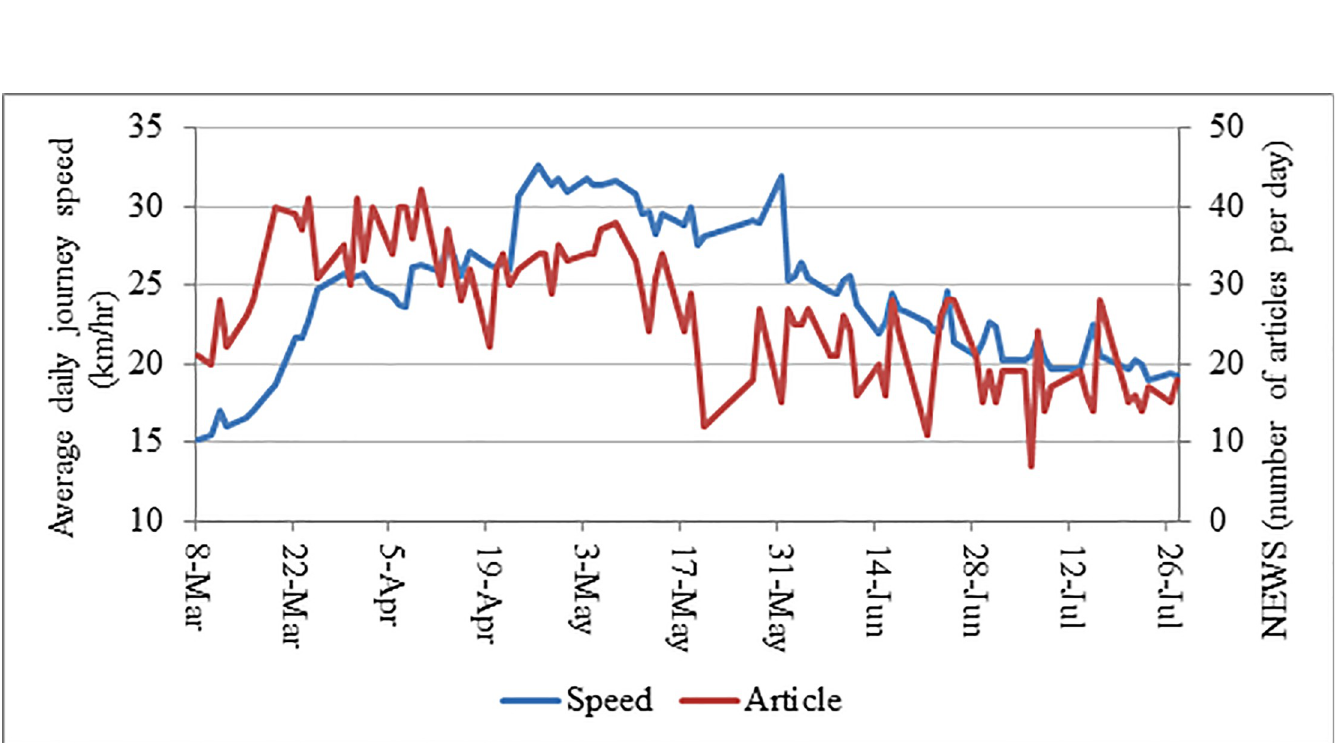
Fig 5. Time series of average daily journey speed ( ADJS) and newspaper coverage on COVID-19 ( PC ).